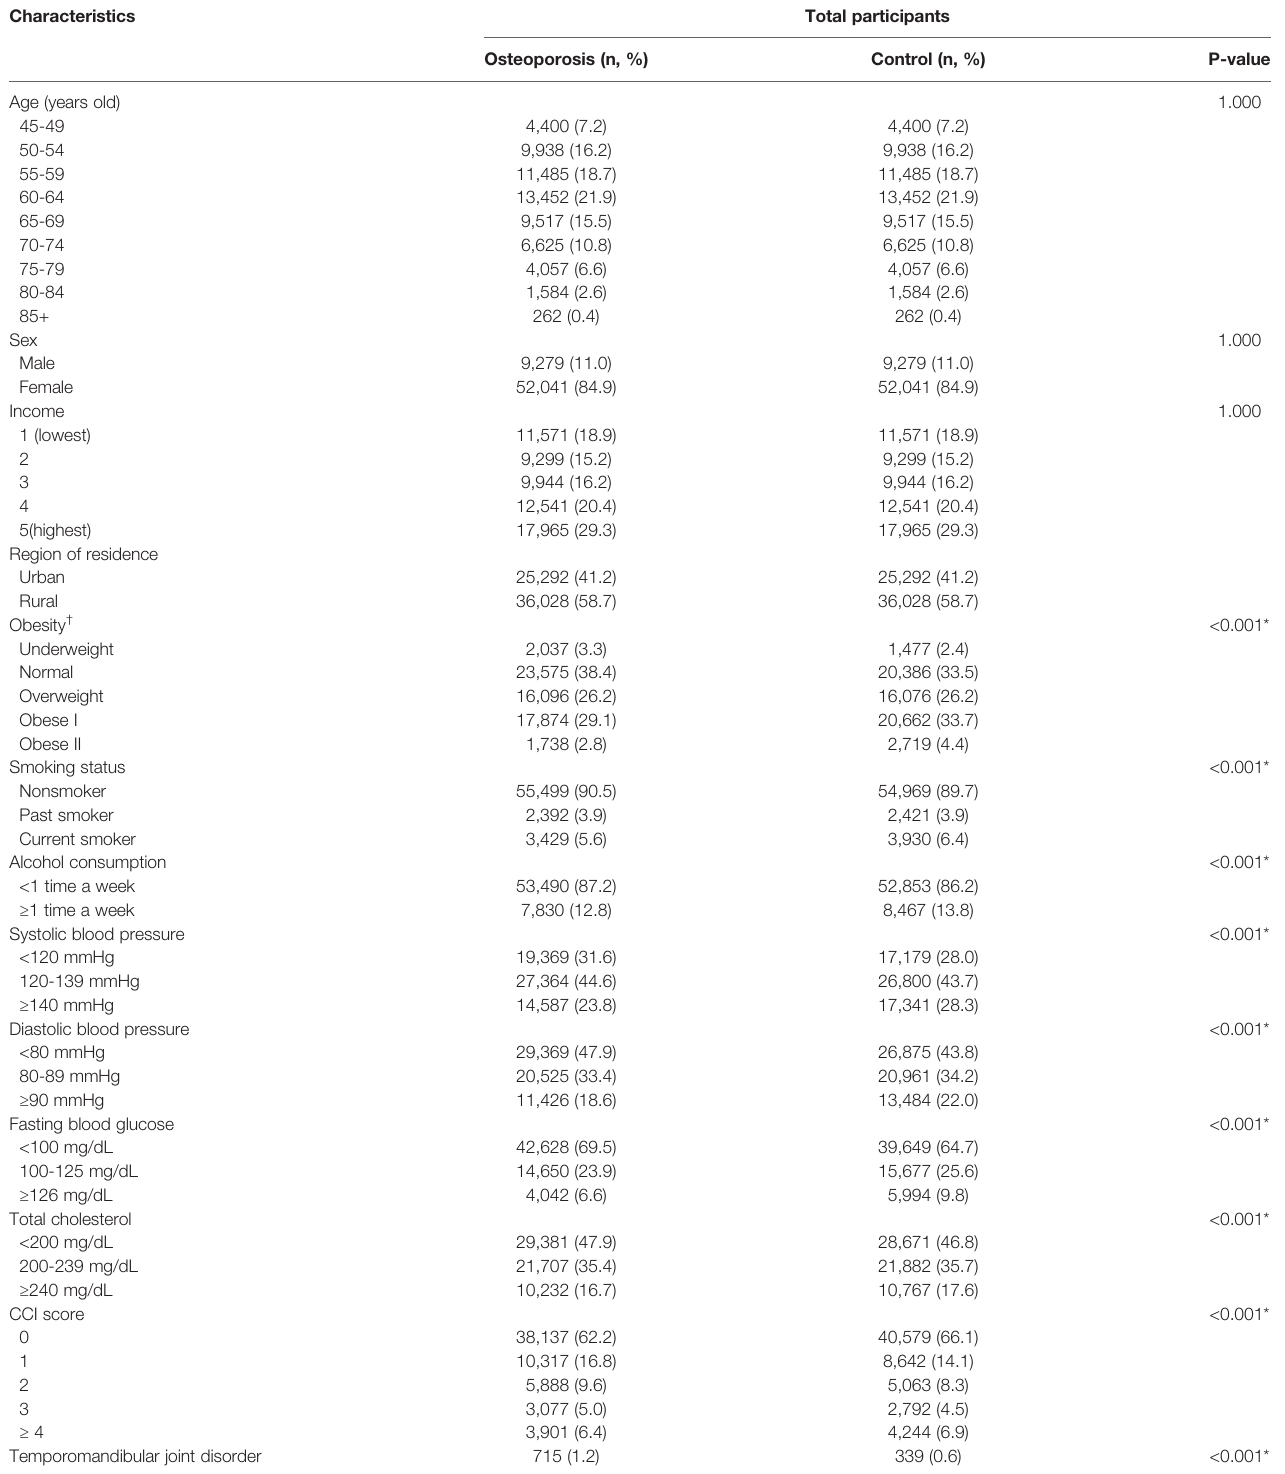
TABLE 1 | General Characteristics of Participants.